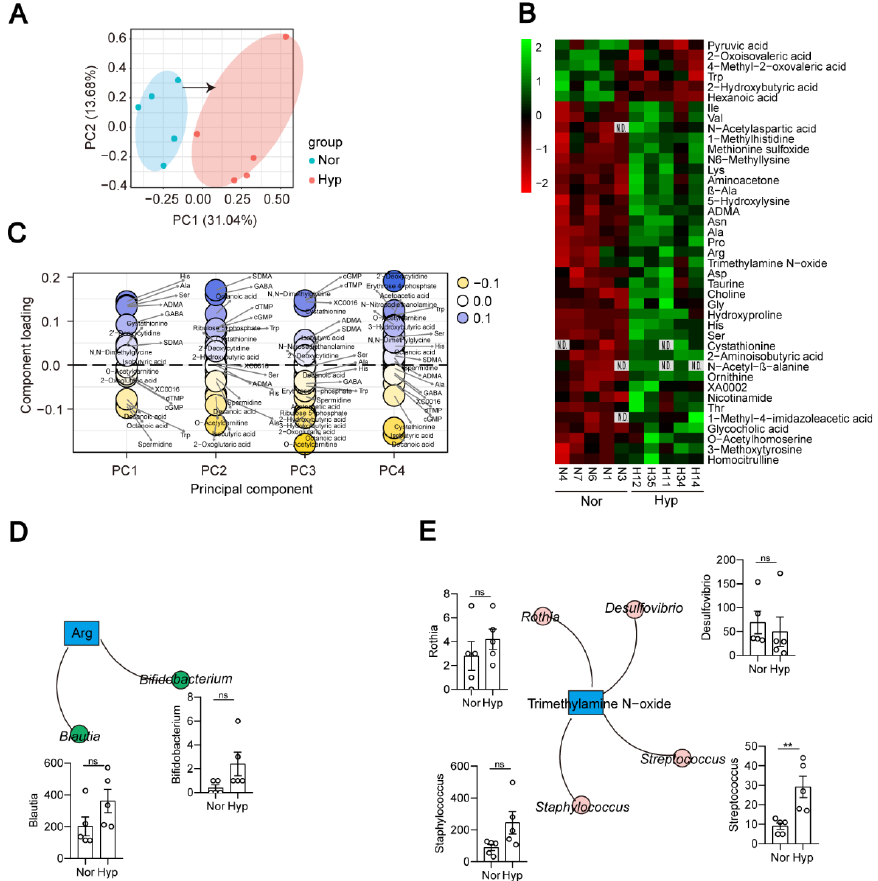
Figure 6. Metabolites of Hyp-induced PH rats ( n = 5) are distinguished from those of normoxia rats ( n = 5). ( A ) PCA scatter plot of the metabolite profile. ( B ) Heatmap analysis of differential metabolites between the Nor and Hyp groups. N1, N3, N4, N6, and N7 represent the codes of rats in the normoxia group (Nor). H11, H12, H14, H34, and H35 represent the codes of rats in the Hyp-induced group (Hyp). ( C ) Identification of metabolite biomarkers. ( D , E ) Correlations between bacterial species and metabolites. Data are presented as the mean ± SEM. Statistical significance was evaluated by Student’s t test (** p < 0.01, ns: no significance, n =